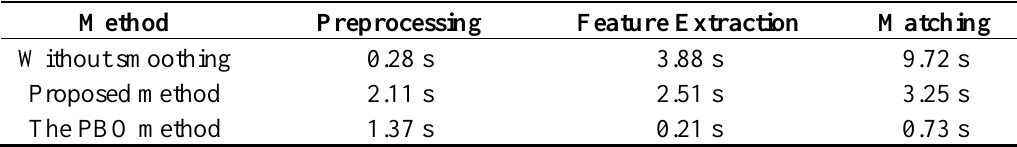
Table 3. The average preprocessing